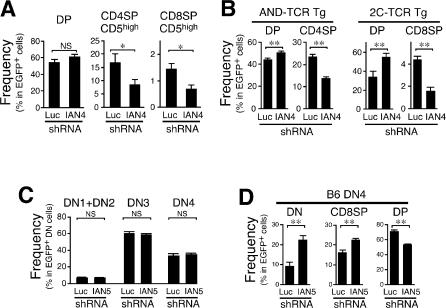
Differential Roles of IAN4 and IAN5 in Thymocyte Development(A) Day 14.5 fetal thymocytes infected with shRNA retroviruses were reconstituted in FTOC. Frequencies of indicated cell populations on day 10 are shown.
Luc shRNA,
n = 4;
IAN4 shRNA,
n = 5.
(B) Day 14.5 fetal thymocytes from AND-TCR-transgenic or 2C-TCR-transgenic mice were infected and reconstituted in C57BL/6 fetal thymus lobes for 6–8 d. For 2C-TCR–transgenic thymocytes, mature CD8SP cells were analyzed by gating CD8SP CD5
high population. AND-
Luc shRNA,
n = 11; AND-
IAN4 shRNA,
n = 12; 2C-
Luc shRNA,
n = 5; 2C-
IAN4 shRNA,
n = 5.
(C) Day 14.5 fetal thymocytes infected with shRNA retroviruses were reconstituted in FTOC (as shown in
Figure 4C–
4F). EGFP
+ thymocytes on day 6 were analyzed for DN subpopulations by staining with anti-CD25 and anti-CD44 antibodies.
Luc shRNA,
n = 6;
IAN5 shRNA,
n = 8.
(D) CD4
−CD8
−CD25
−CD44
− DN4 cells were purified from day 17 fetal thymocytes by depleting the cells expressing CD4, CD8, CD25, or CD44, infected with indicated retroviruses, and reconstituted in FTOC for 2 d;
n = 4.
Bar graphs show means ± standard errors.NS, not significant (
p ≥ 0.05);
*
p < 0.05;
**
p < 0.01.